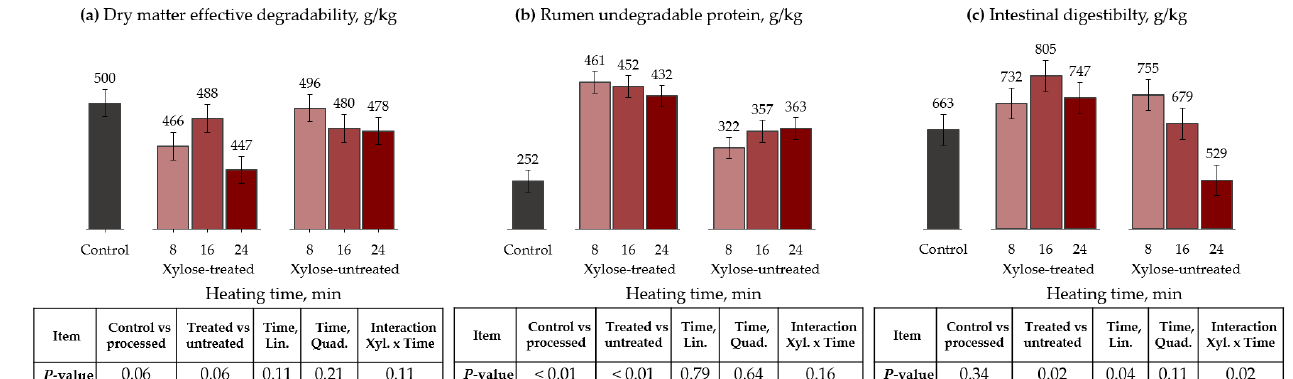
Figure 1. Effects of autoclave heating and xylose treatment on dry matter effective degradability ( a ,